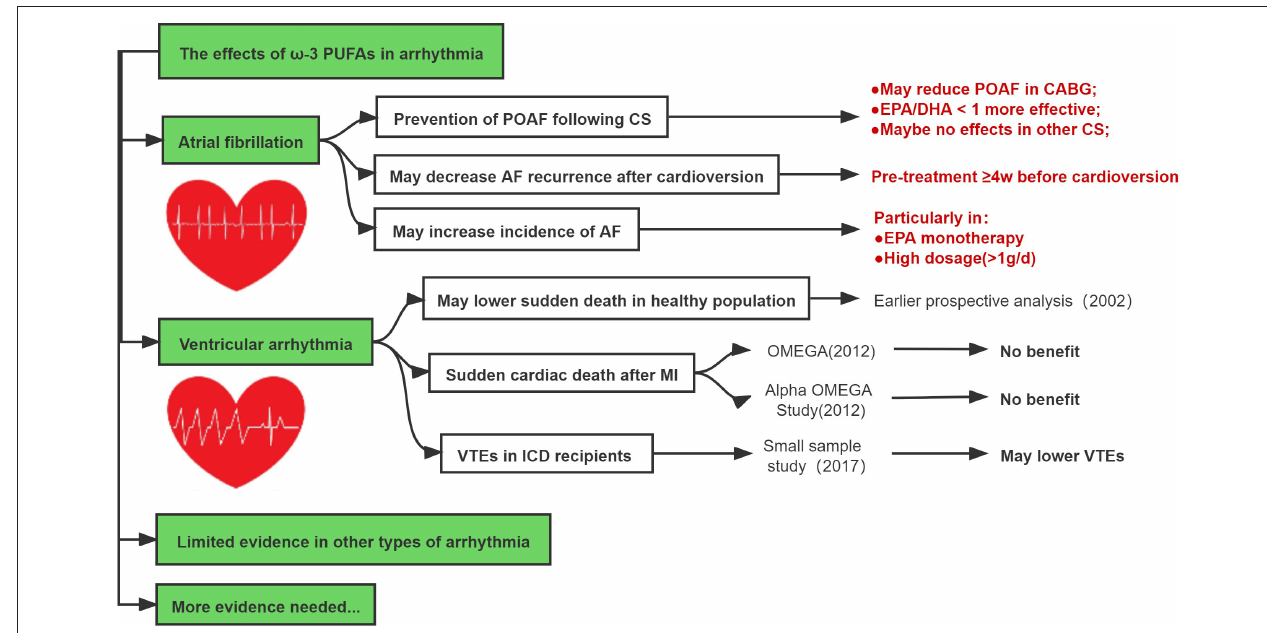
FIGURE 5 | The effects of ω -3 PUFAs in atrial fibrillation and ventricular arrhythmia.